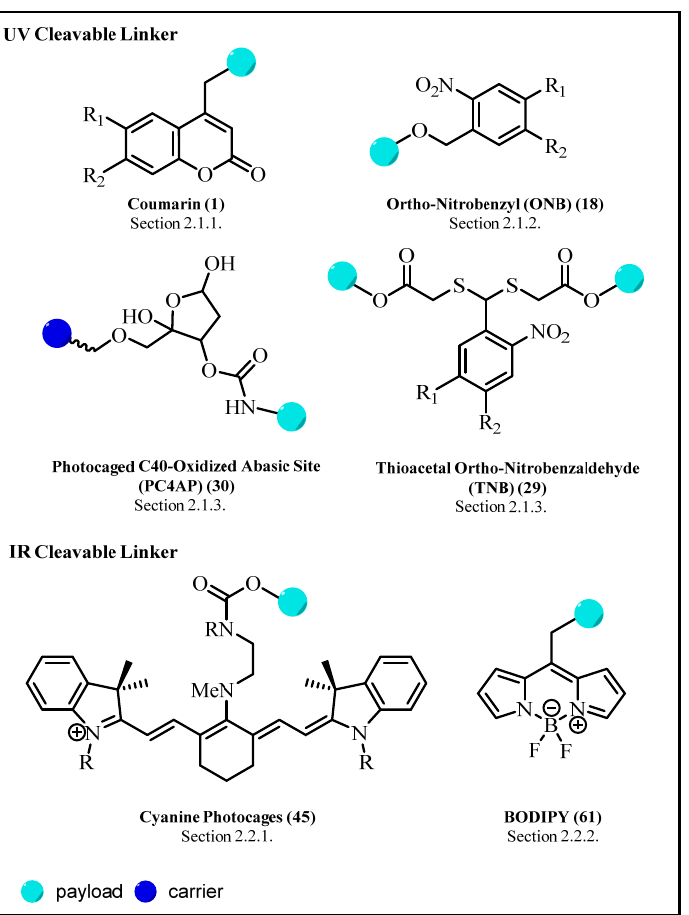
Figure 2. Overview of the structures of UV/Vis and NIR cleavable linkers discussed in this paper.